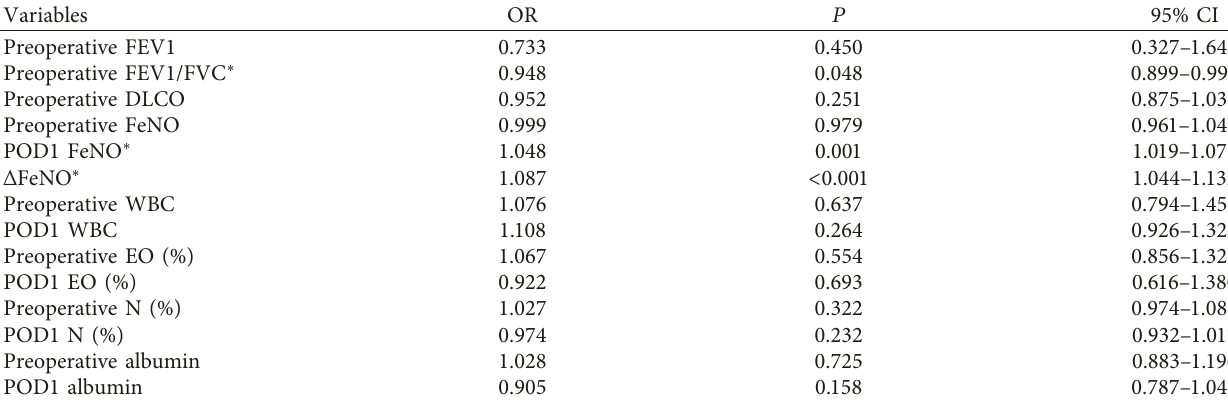
Figure 4: ROC curve was performed to evaluate the sensitivity and specificity of post-op-FeNO and ∆ FeNO. FeNO: fractional exhaled nitric oxide; ∆ FeNO: change in FeNO; ROC curve: receiver operating characteristic curve. Table 3: Bivariate analysis of FeNO and routine perioperative